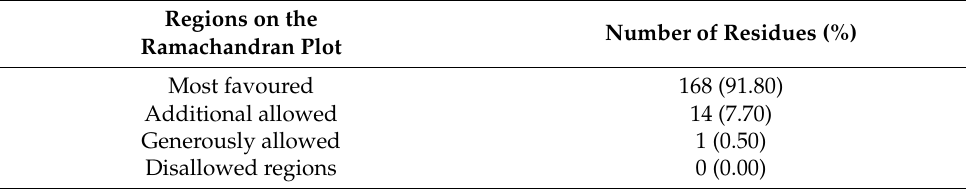
Table 4. Ramachandra plot summary for the KpNNAT model. Regions on the Number of Residues (%) Ramachandran Plot Most favoured 168 (91.80) Additional allowed 14 (7.70) Generously allowed 1 (0.50) Disallowed regions 0 (0.00)